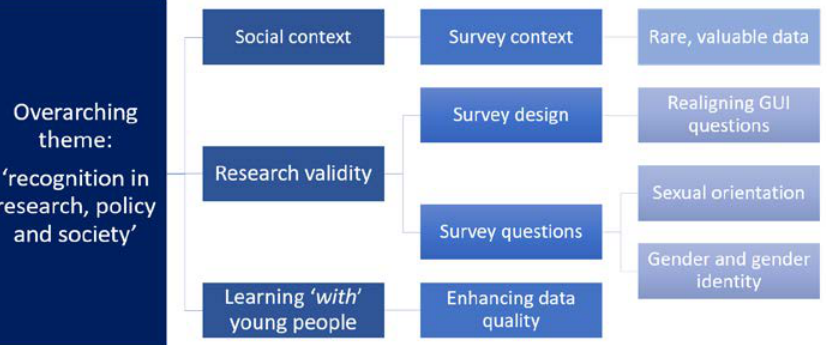
Figure 2. Coding concepts and developing categories for overarching theme “recognition in research, policy and society”.